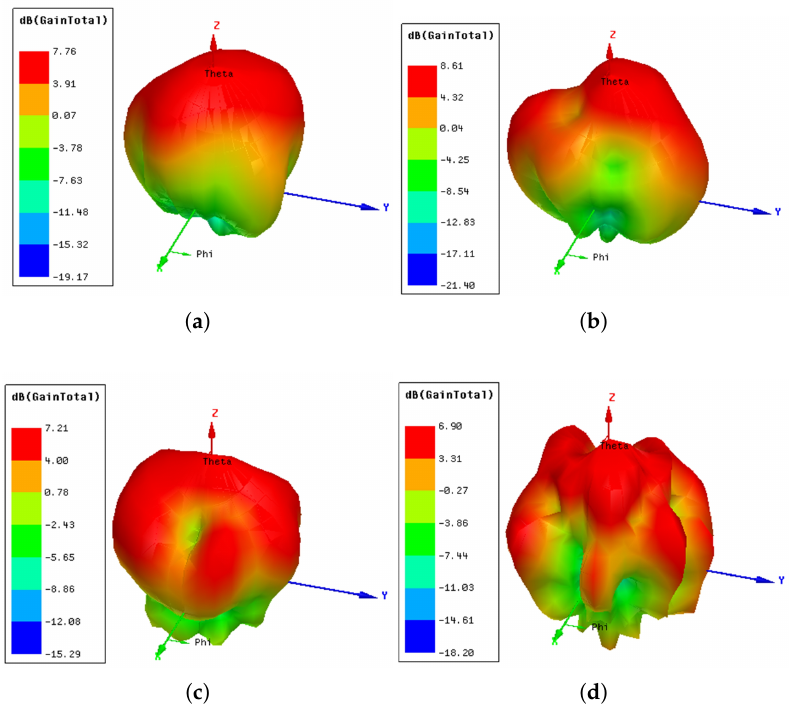
Figure 7. The 3D gain plot of the proposed antenna in dB ( a ) at 28.3 GHz, ( b ) at 38.1 GHz, ( c ) at 46.6 GHz, and ( d ) at 60.0 GHz.